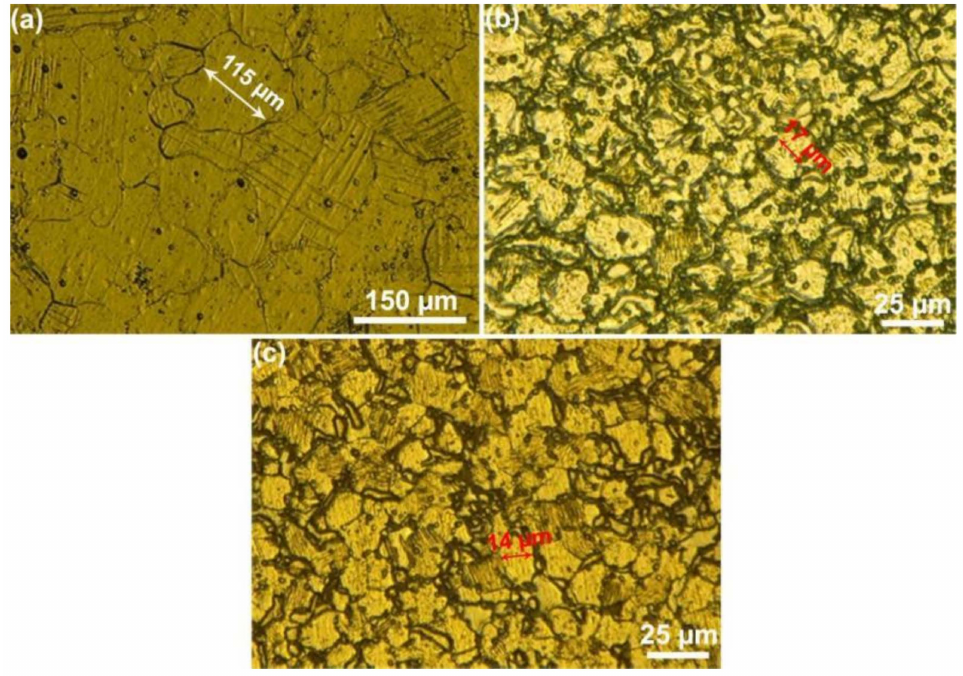
Figure 2. Metallographic images and grain sizes of all fabricated materials: ( a ) M0, ( b ) M1, ( c )